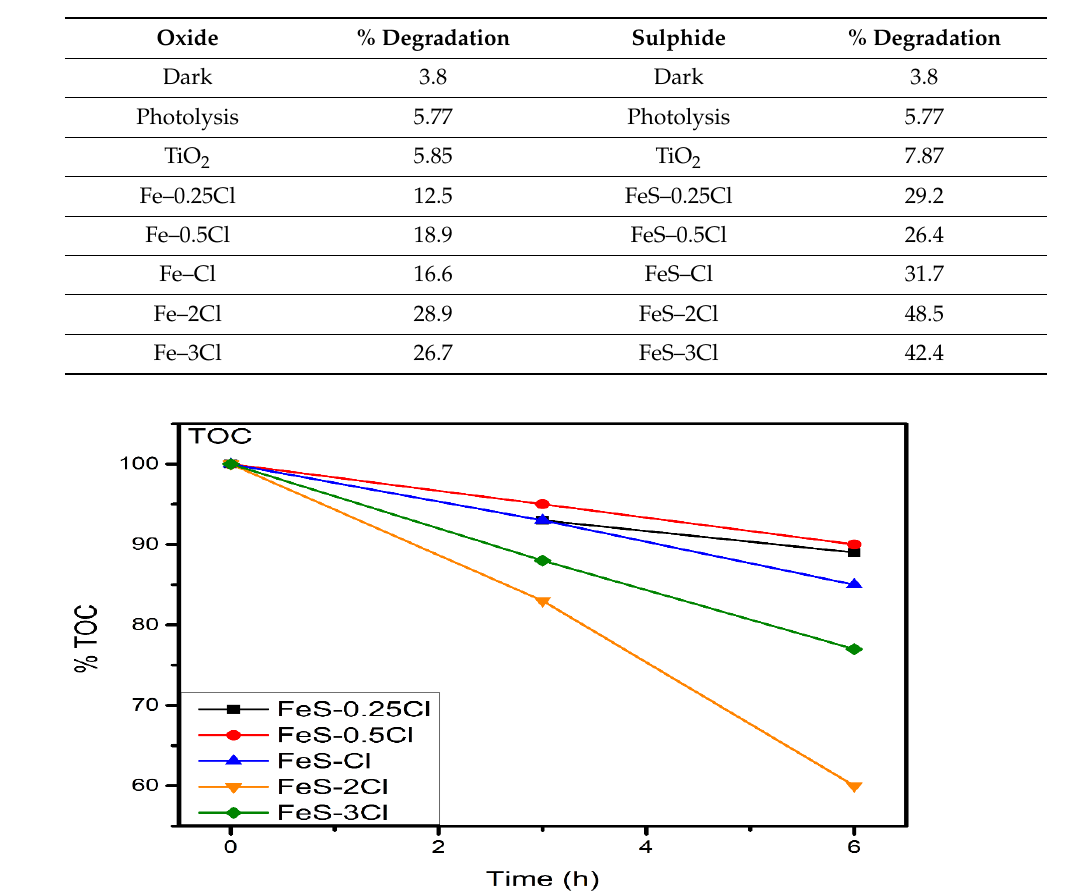
Figure 13. Phenol degradation with oxide and sulphide catalyst. Table 6. Degradation results on visible-light region.